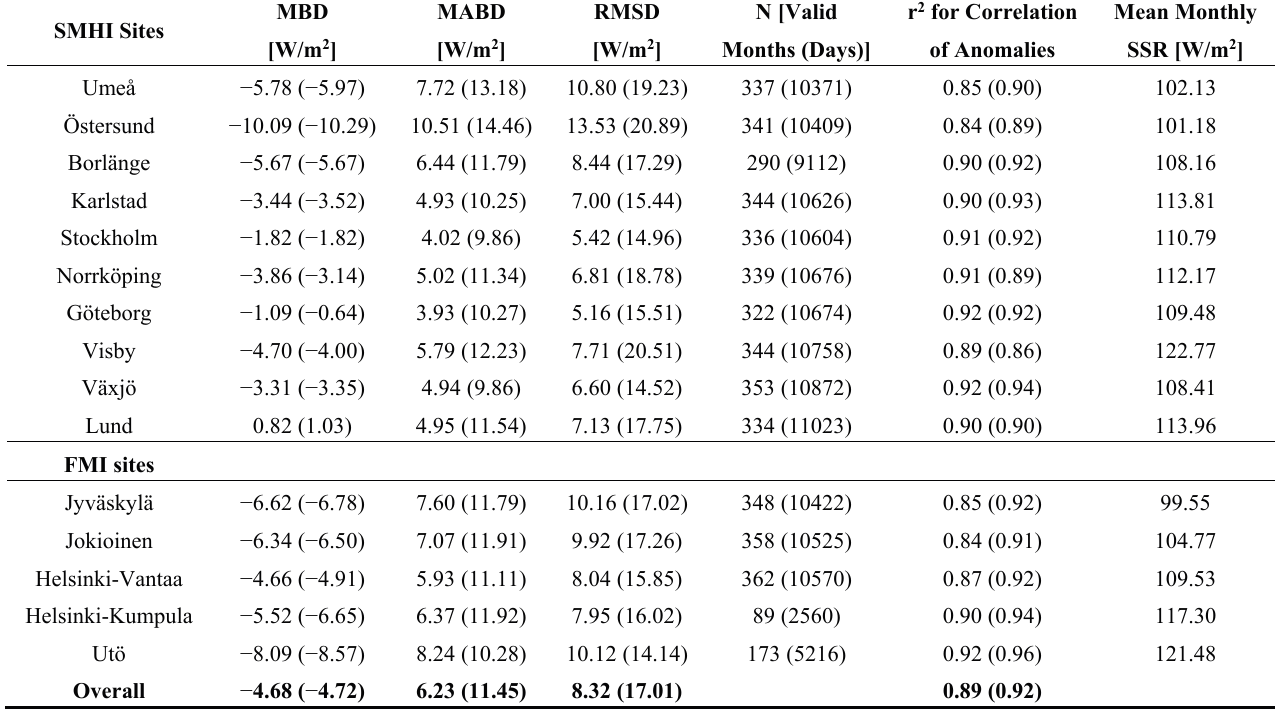
Table 4. SARAH validation results for 1983–2013. Numbers in parentheses are the results for the daily mean product. Mean monthly SSR is the 1983–2013 average SSR from valid in situ